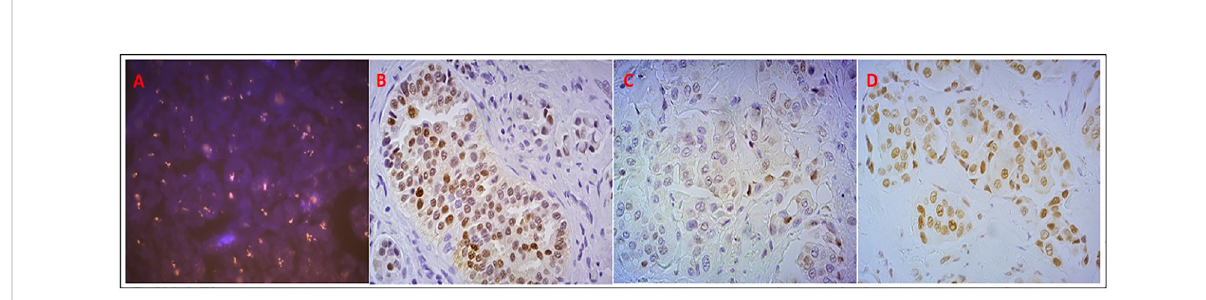
FIGURE 3 Analysis of AR status in the patient who had stable disease with DHEA: (A) AR copy number, evaluated by FISH, showing clusters of orange signals; (B) AR positive nuclear expression by IHC; (C) AR pSer210-213 positive but weak nuclear and cytoplasmic expression; (D) AR pSer650 positive nuclear